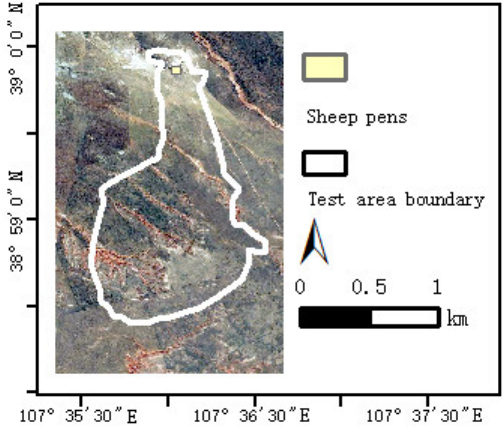
Figure 2. Location of the test area.